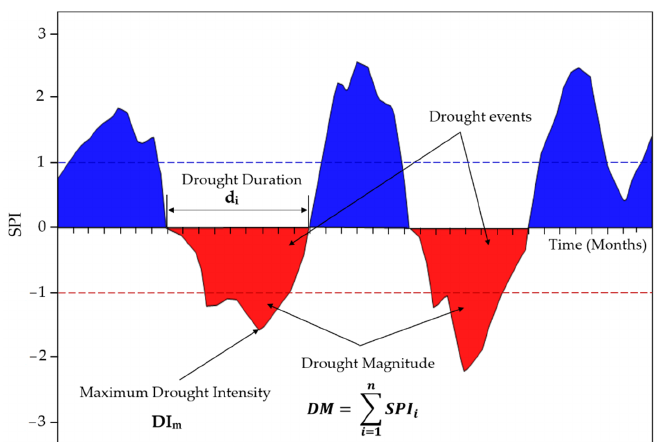
Figure 4. Definition of drought characteristics based on the SPI index (blue dashed line shows one standard deviation wetter than average, while the red dashed line shows one standard deviation drier than average (modified from [105]).